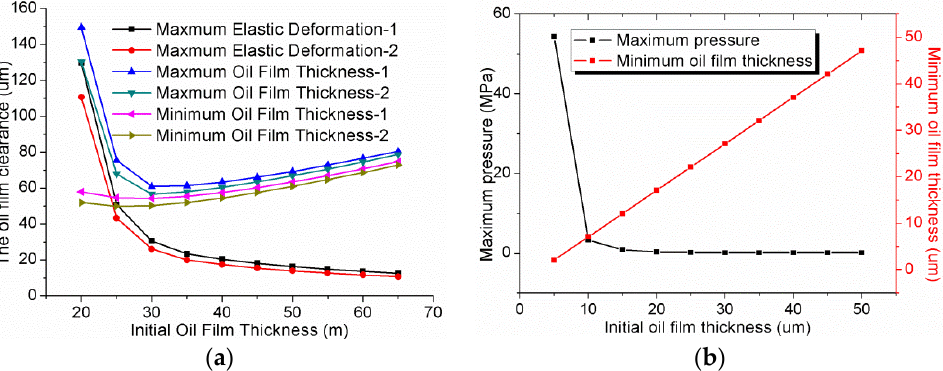
Figure 13. Effect of the inclination on the oil film clearance and pressure. ( a ) The oil film thickness and the elastic deformation with the initial oil film thickness; ( b ) the minimum oil film thickness and maximum pressure with the initial oil film thickness.